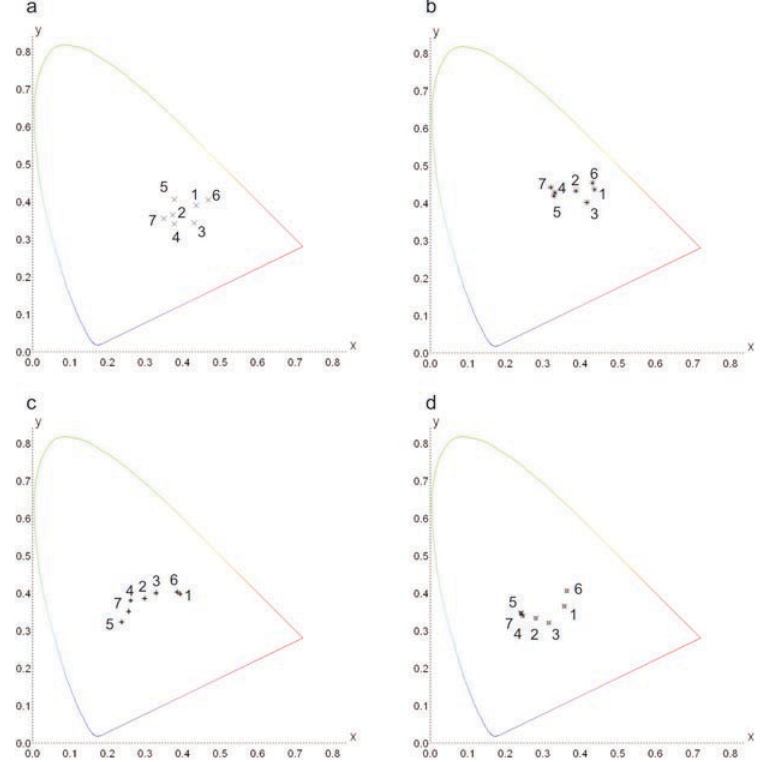
Figure 5. Ho,Nd:YAB (a); Ho,Cr:YAB (b), Nd,Cr:YAB (c) and Ho,Nd,Cr:YAB (d) crystal chromaticities in the CIE1931(xy) chromaticity plane. The numbers indicate the illumination with the different light sources: 1: fl. lamp type 32, 2: fl. lamp type 33 3: fl. lamp type 840 4: fl. lamp type 960 5: white LED, 6: tungsten lamp, 7: daylight CIE D5500.